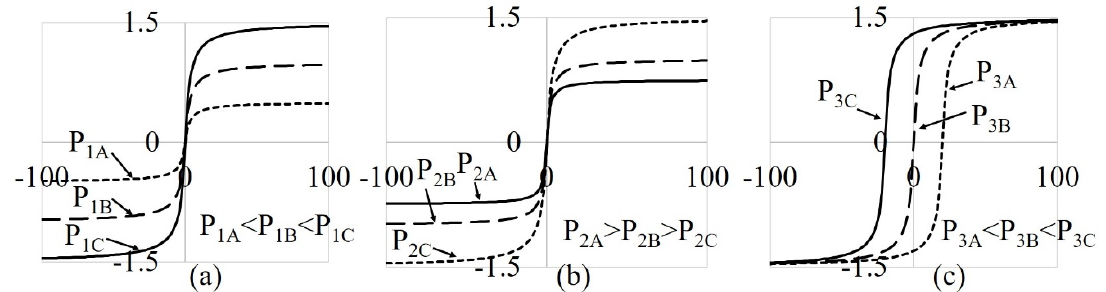
Figure 6. Meaning of parameters: ( a ) P 1 ; ( b ) P 2 ; ( c ) P 3 used in the Elliot expression.